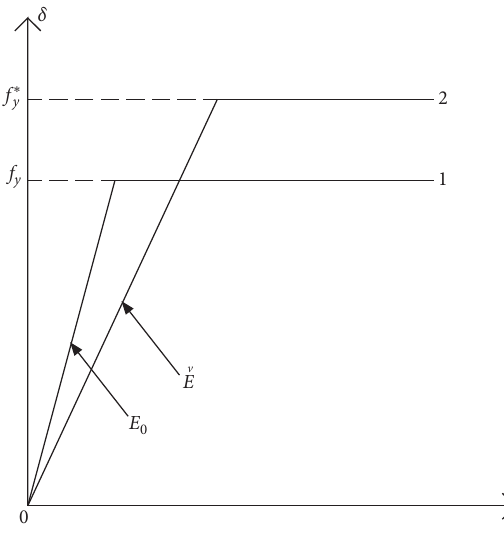
Figure 11: Stress-strain relationship of